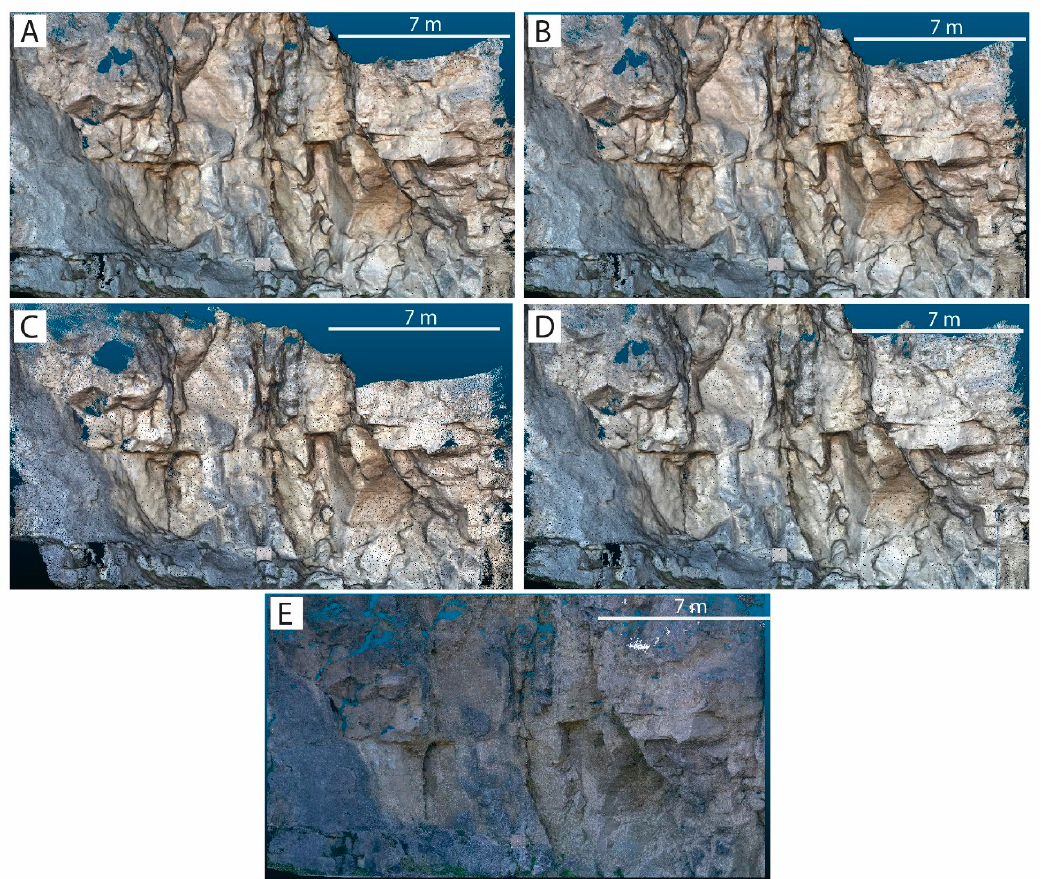
Figure 6. Three-dimensional models obtained using a calibrated digital camera ( A ), non-calibrated digital camera ( B ), smartphone 1 ( C ), smartphone 2 ( D ) and laser scanning (LS) ( E ). View of models towards the east.